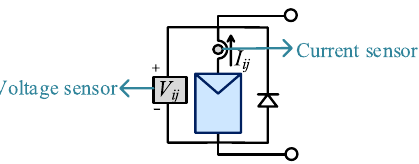
Fig. 3 Position of the electrical parameter measurement sensors in the PV